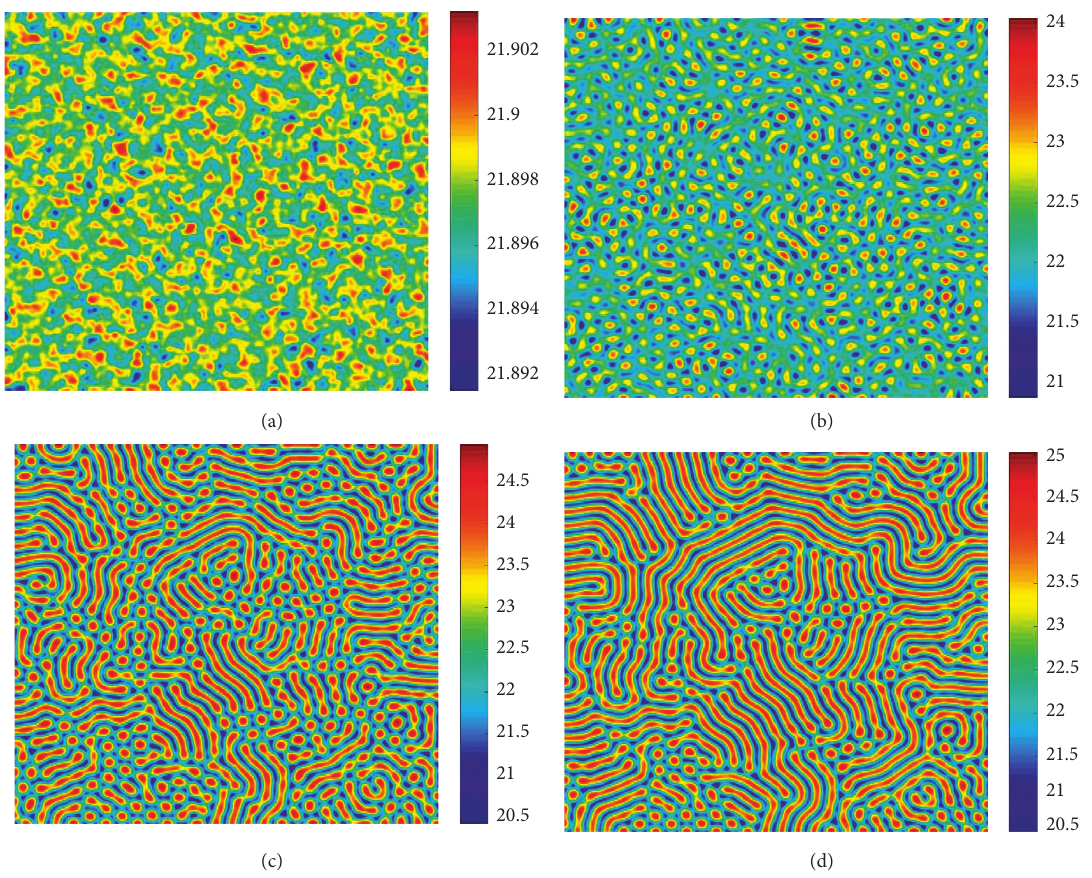
Figure 4: Iterations of the mixture of hot spots and stripes of the predator with c � 0 . 0118; the other parameters are set as in Table 4. Iterations: (a) 0, (b) 15,000, (c) 50,000, and (d)